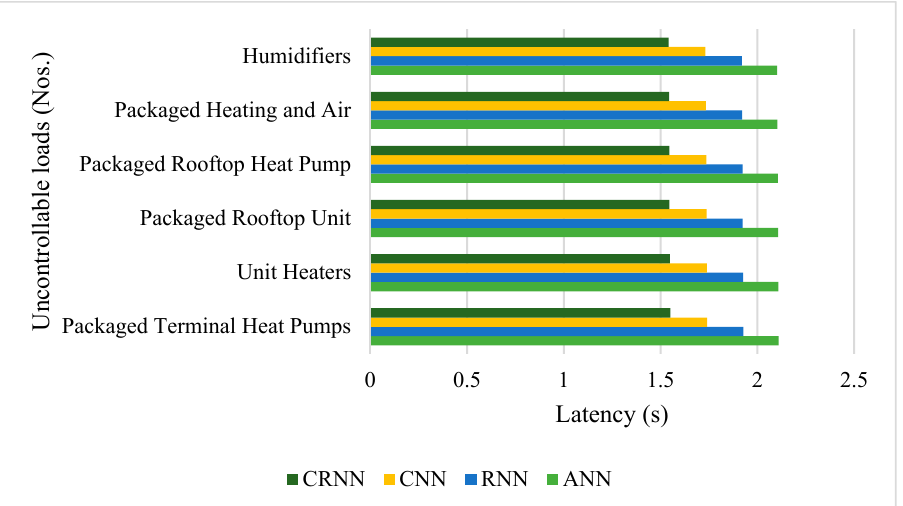
Figure 13. Latency (s) with more smart buildings.